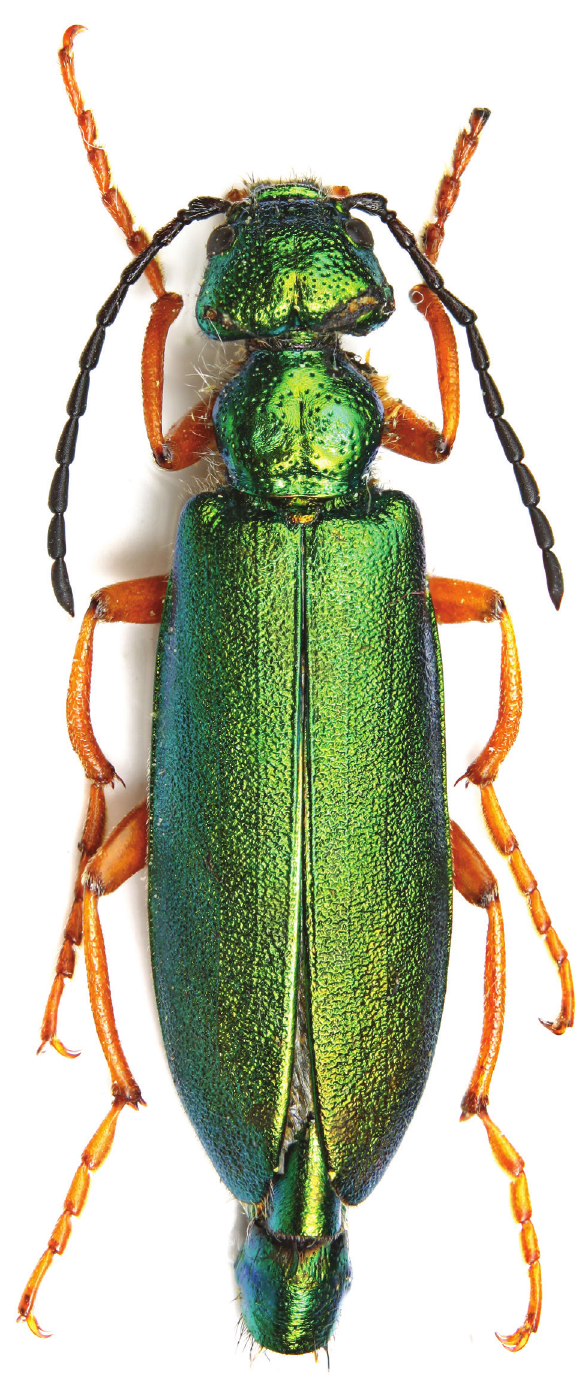
Figure 1. Teratolytta krejciki sp. n., habitus, male, dorsal